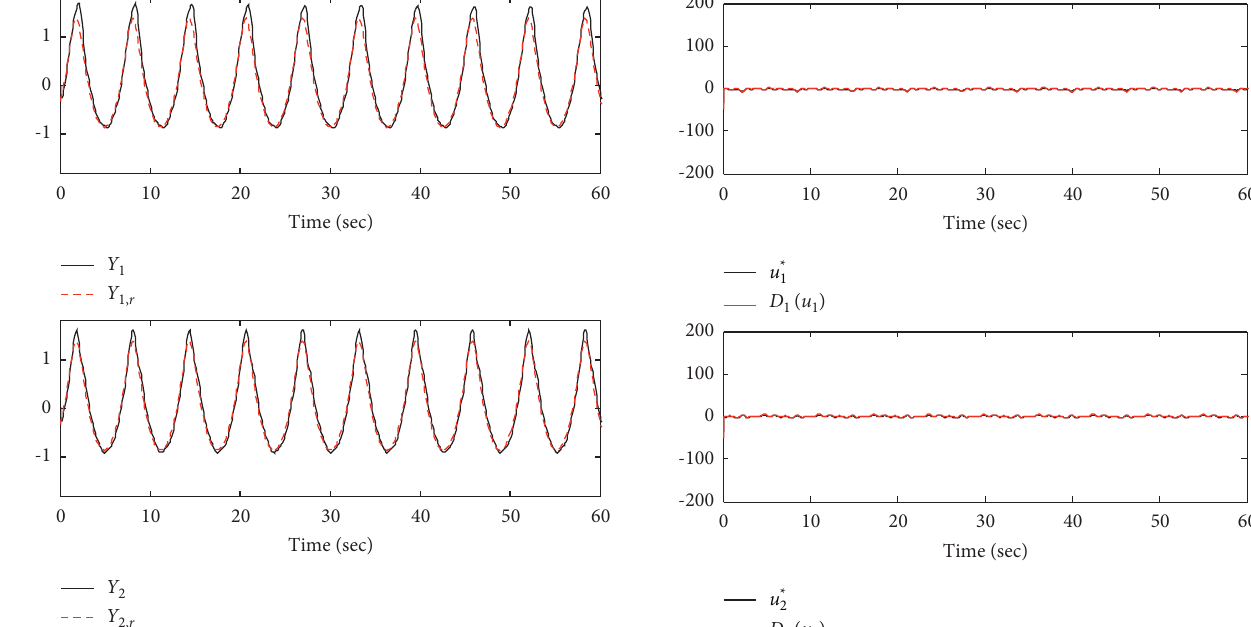
i and reference signals